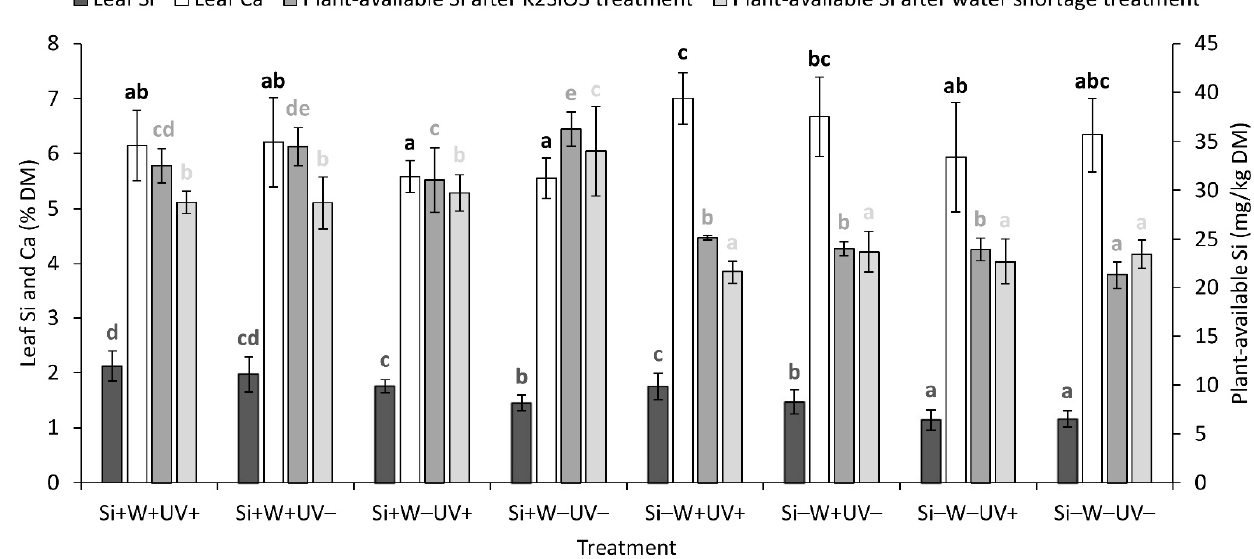
Figure 3. Leaf Si and Ca contents for cucumber plants, grown under the eight treatments ( n = 10), and plant-available Si level in the soil after K 2 SiO 3 treatment and after water shortage treatment for the eight treatments ( n = 5). Different letters indicate significant differences between the treatments for each of the four parameters separately.